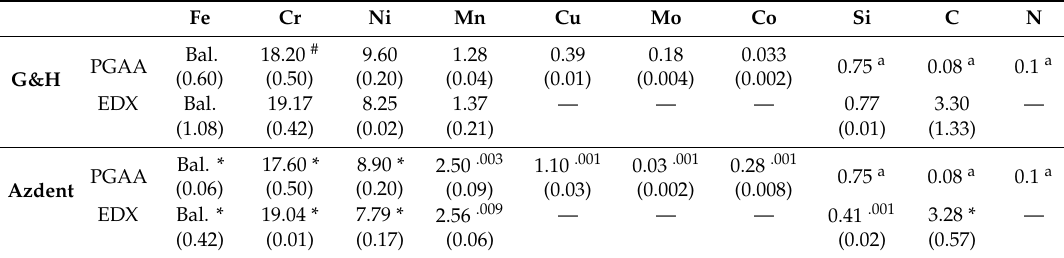
Table 1. Quantitative elemental composition as wt-% (SD) determined by neutron PGAA 238 and EDX, for the G&H and Azdent stainless steel archwire samples.